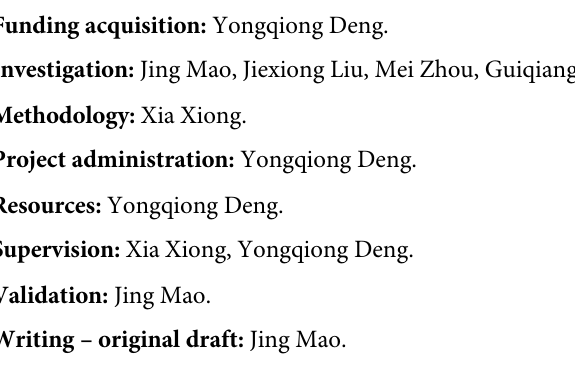
S1 Table. The different proteins between SSc patients and